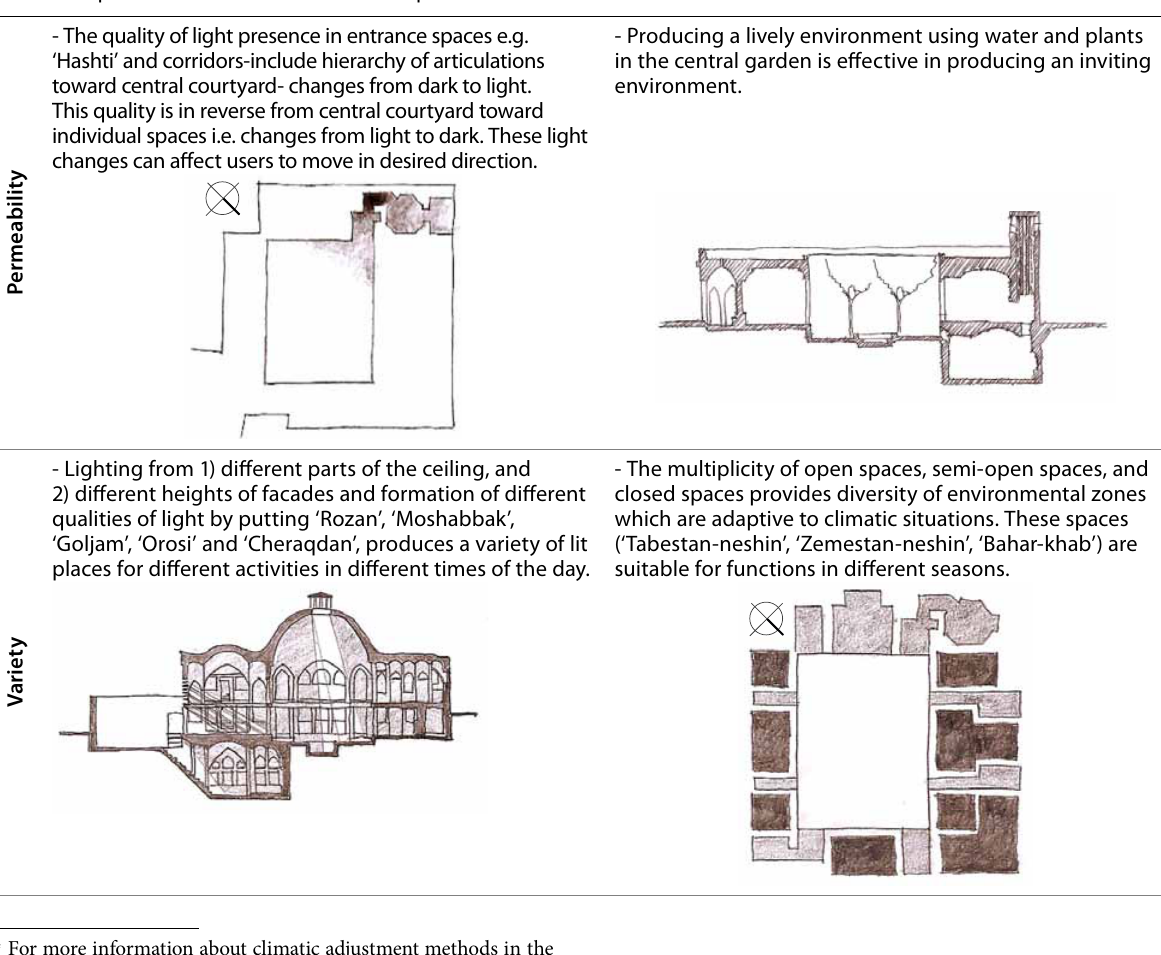
Table 2. responsiveness to environmental